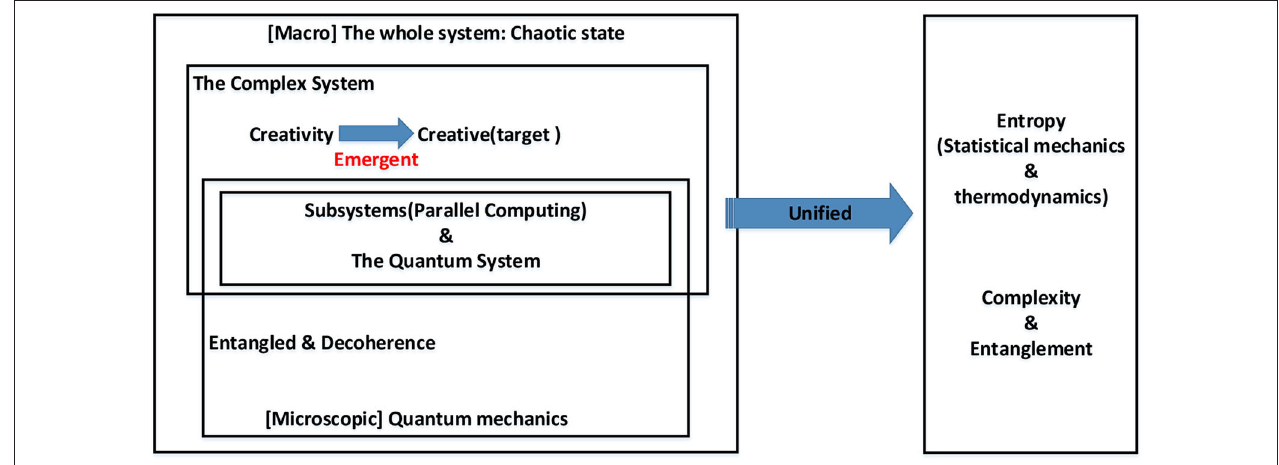
FIGURE 9 | The relationship between macroscopic complex systems and microscopic quantum